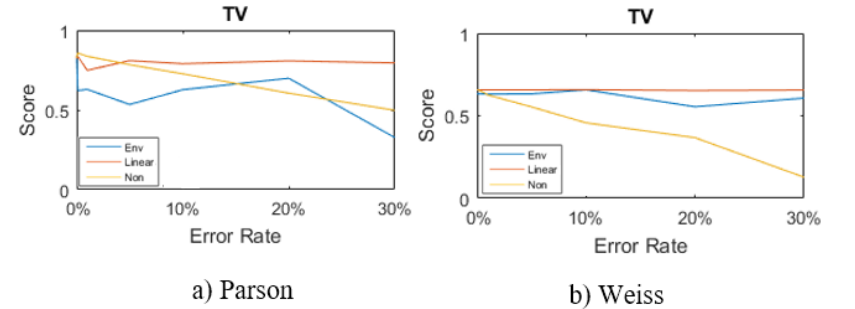
Figure 10. F1 score of the load disaggregation methods.